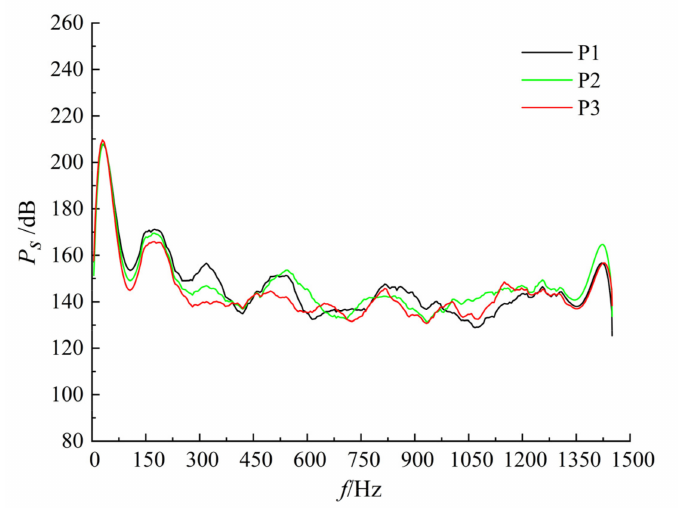
Figure 14. Spectrum diagram at monitoring points of guide